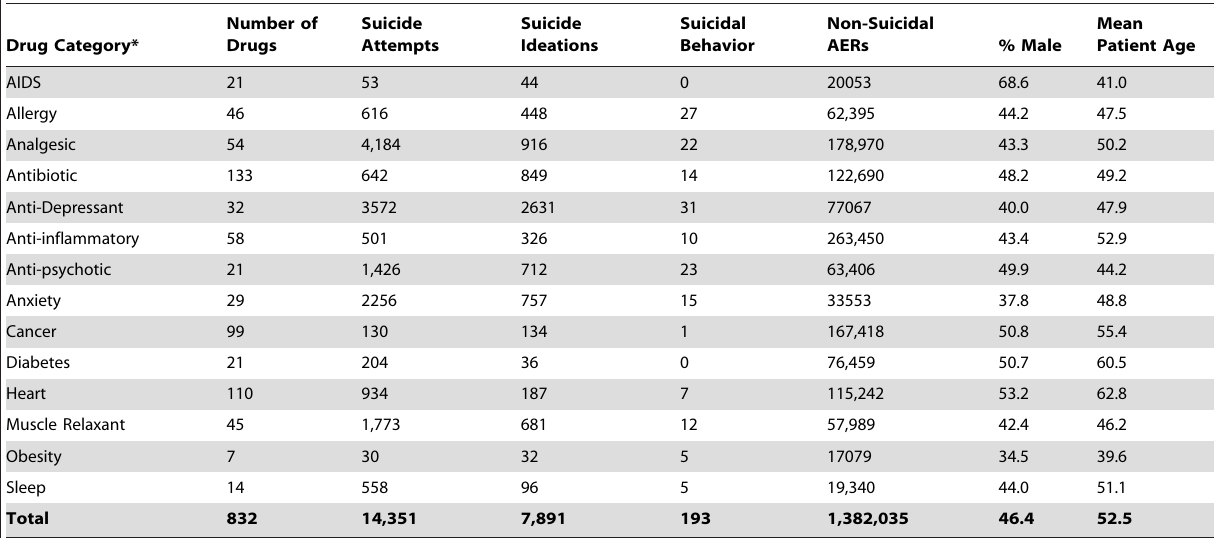
* A drug can belong in more than one category. The ‘‘total’’ line at the bottom is not the sum of the rows above it. doi:10.1371/journal.pone.0007312.t001 PLoS ONE |